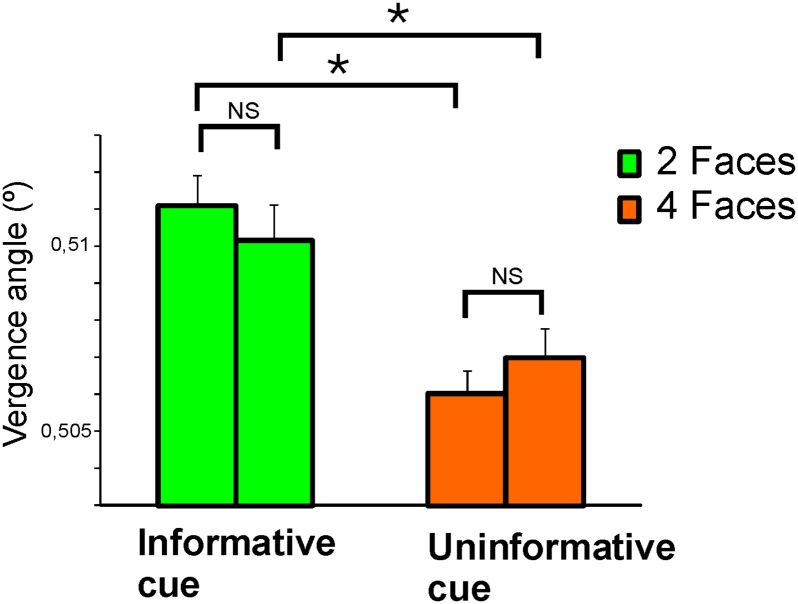
Mean sizes of angle of vergence for the different face conditions.Bars denote 2/4 face condition. Error bars are SEM. Asterisks denote statistical significance. NS = not significant.